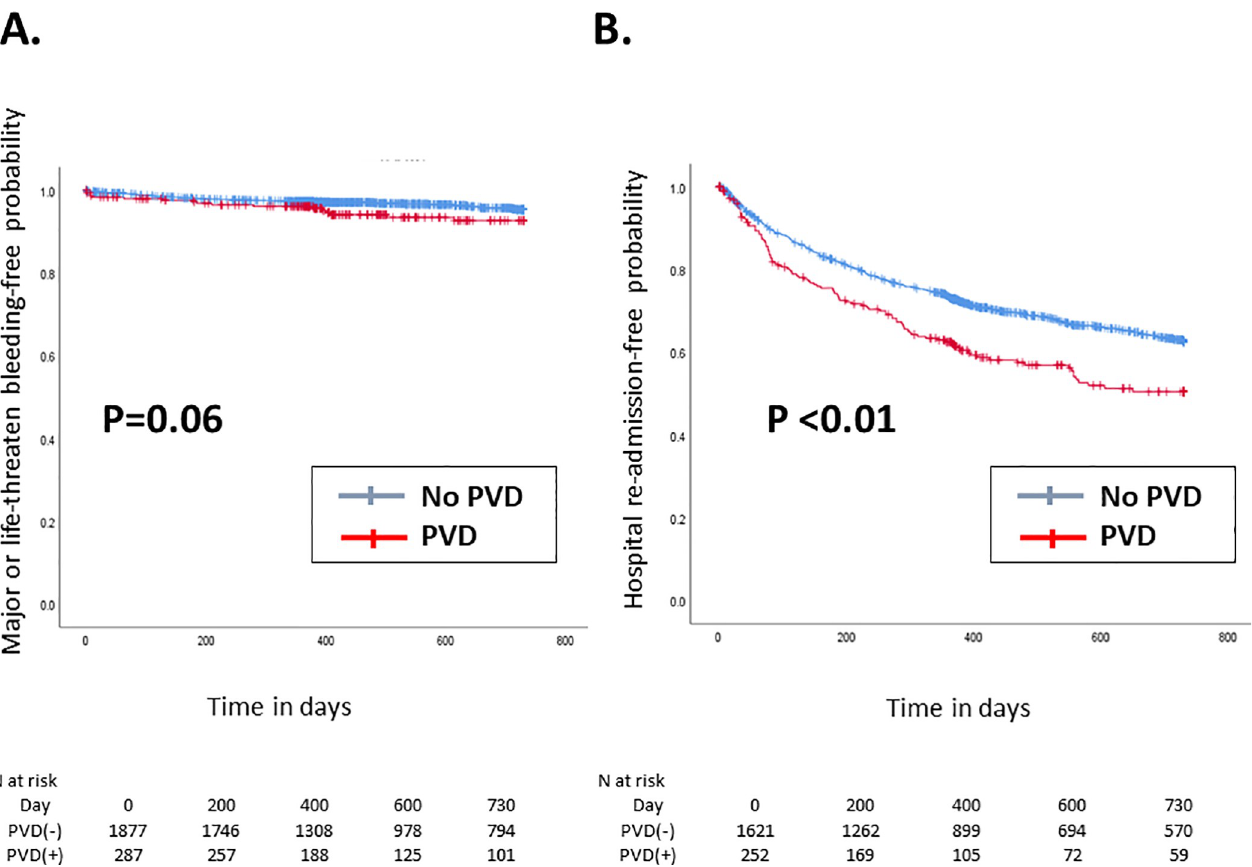
Fig 4. Kaplan–Meier curve of the 2-year (A) major or life-threatening bleeding-free and (B) hospital readmission-free rates. The red and blue lines indicate patients with and without PVD, respectively. PVD = polyvascular